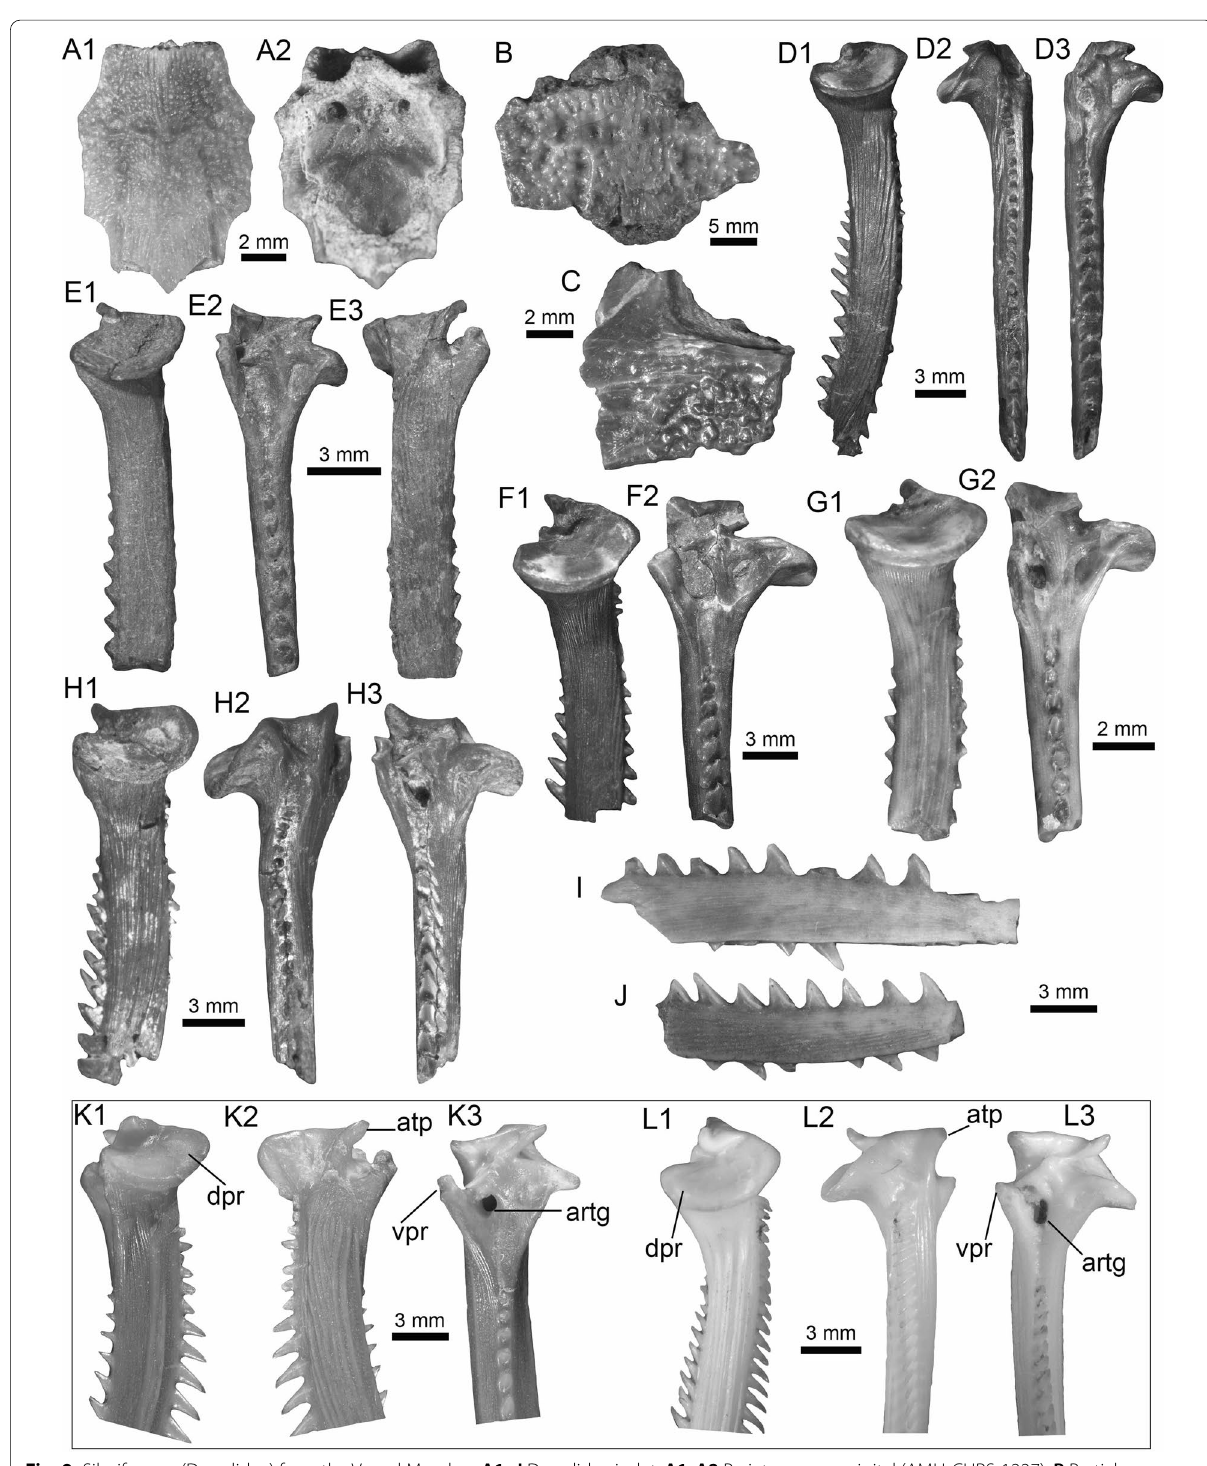
Fig. 9 Siluriformes (Doradidae) from the Vergel Member. A1 – J Doradidae indet. A1 , A2 Parieto‑supraoccipital (AMU‑CURS‑1227). B Partial parieto‑supraoccipital (AMU‑CURS‑1170). C Partial left cleithrum (AMU‑CURS‑1175). D1 – J Pectoral‑fin spines ( D1 – H3 AMU‑CURS‑1234 and I , J AMU‑CURS‑1233), position: right ( D1 – H3 ) and indet. ( I , J ). K1 – L3 Right pectoral‑fin spines of extant Anadoras wedellii ( K1 – K3 AUM‑45441) and Scorpiodoras heckelii ( L1 – L3 MHNLS‑17959). Views: anterior ( D2 , H2 , L2 ), dorsal ( A1 , B , C , D1 , E1 , F1 , G1 , H1 , K1 , L1 ), posterior ( D3 , E2 , F2 , G2 , H3 , K3 , L3 ), ventral ( A2 , E3 , K2 ), and indet. ( I , J ). atp anterior process, artg articular grove, dpr dorsal process, vpr ventral